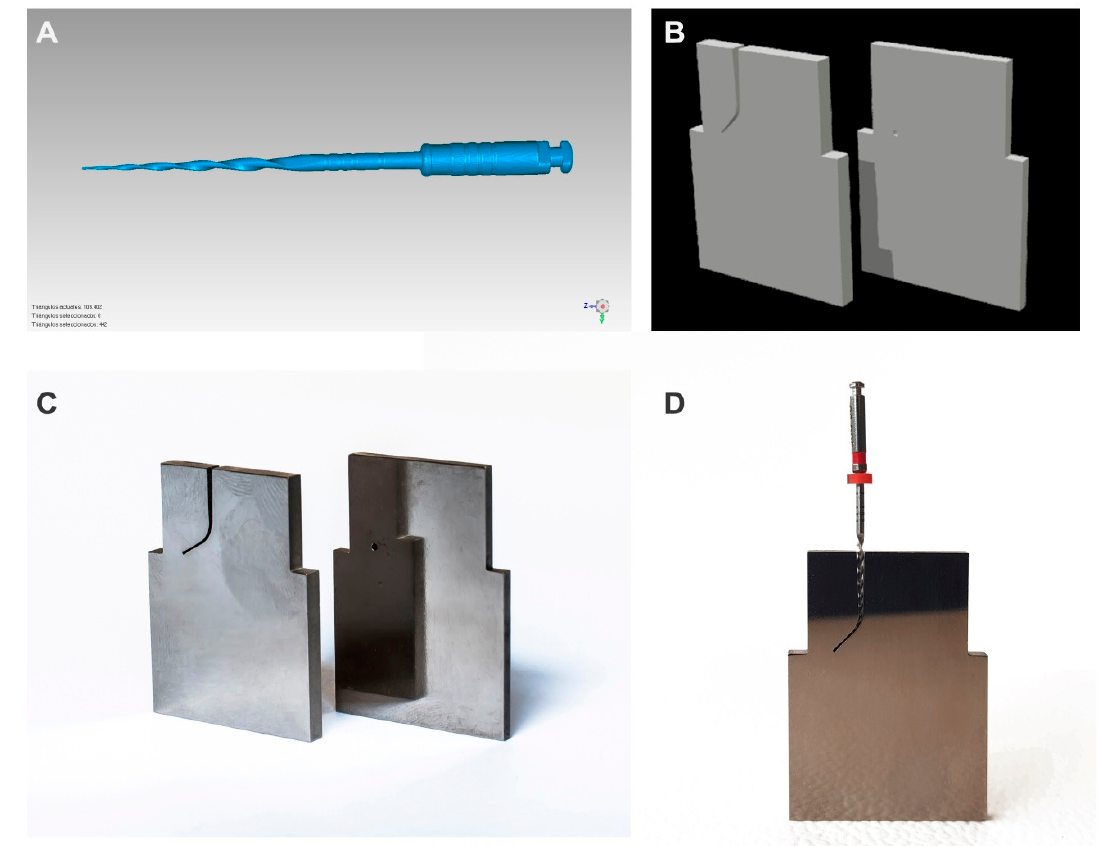
Figure 2. ( A ) Stereolithography (STL) file of the endodontic rotary file; ( B ) STL file of the artificial root canal; ( C ) artificial root canal manufactured by electrical discharge machining (EDM) and ( D ) endodontic rotary file in intimate contact with the artificial root canal (D).